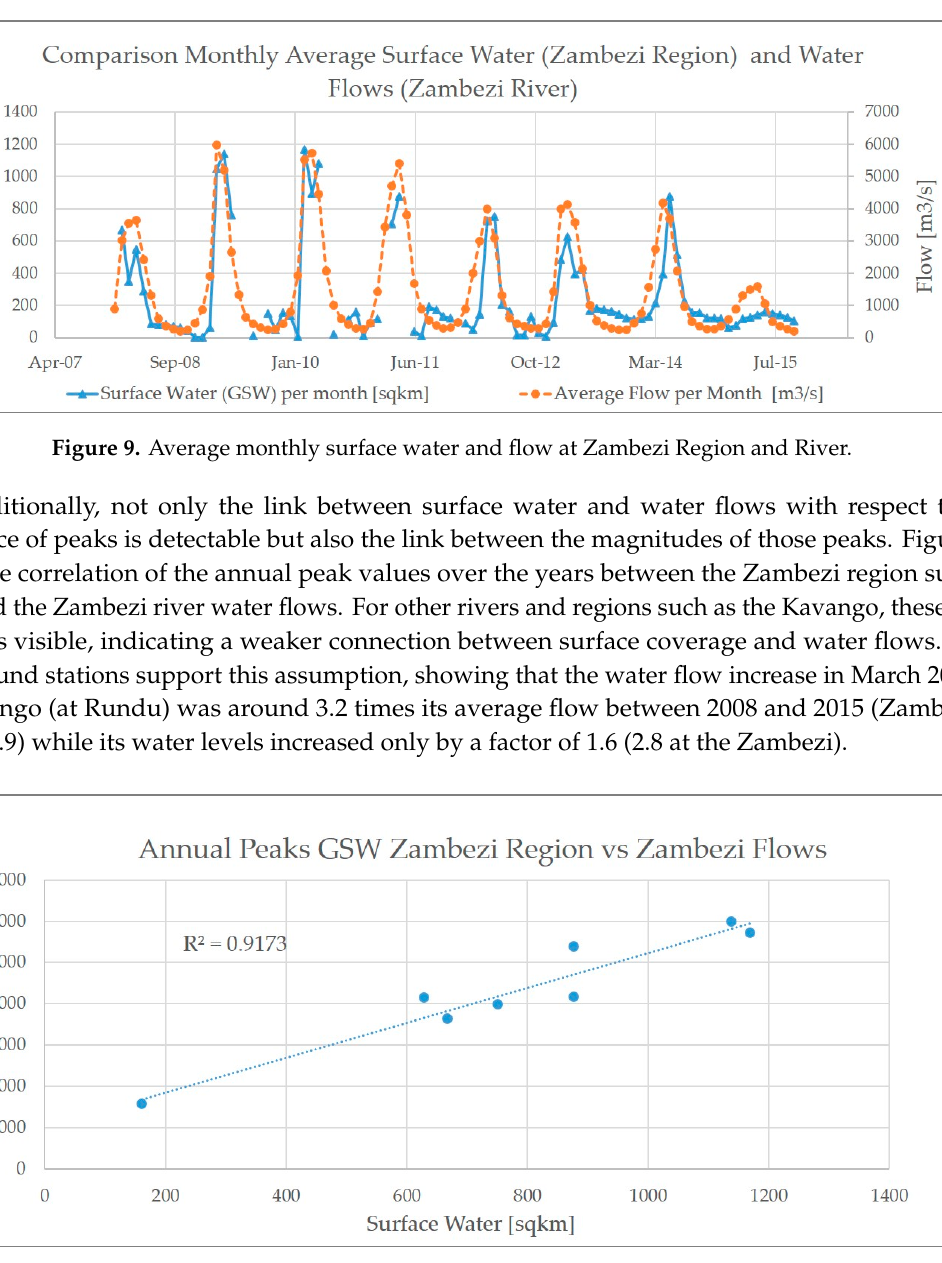
Figure 8. Monthly Average Surface Water and Water Level at Zambezi Region and River.